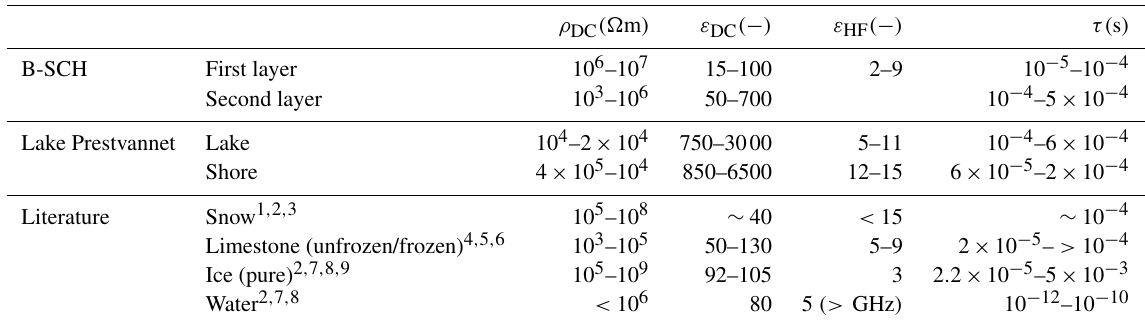
Table 1. Results of the 2-D inversions on profile B-SCH and the profile on Lake Prestvannet and comparison with literature values for snow, ice, water and limestone, which is expected as bedrock material on B-SCH. The characteristic parameters from the inversions are given as the range for the two horizontal layers for profile B-SCH and the two vertical separated regions of lake and shore for the profile on Lake Prestvannet.